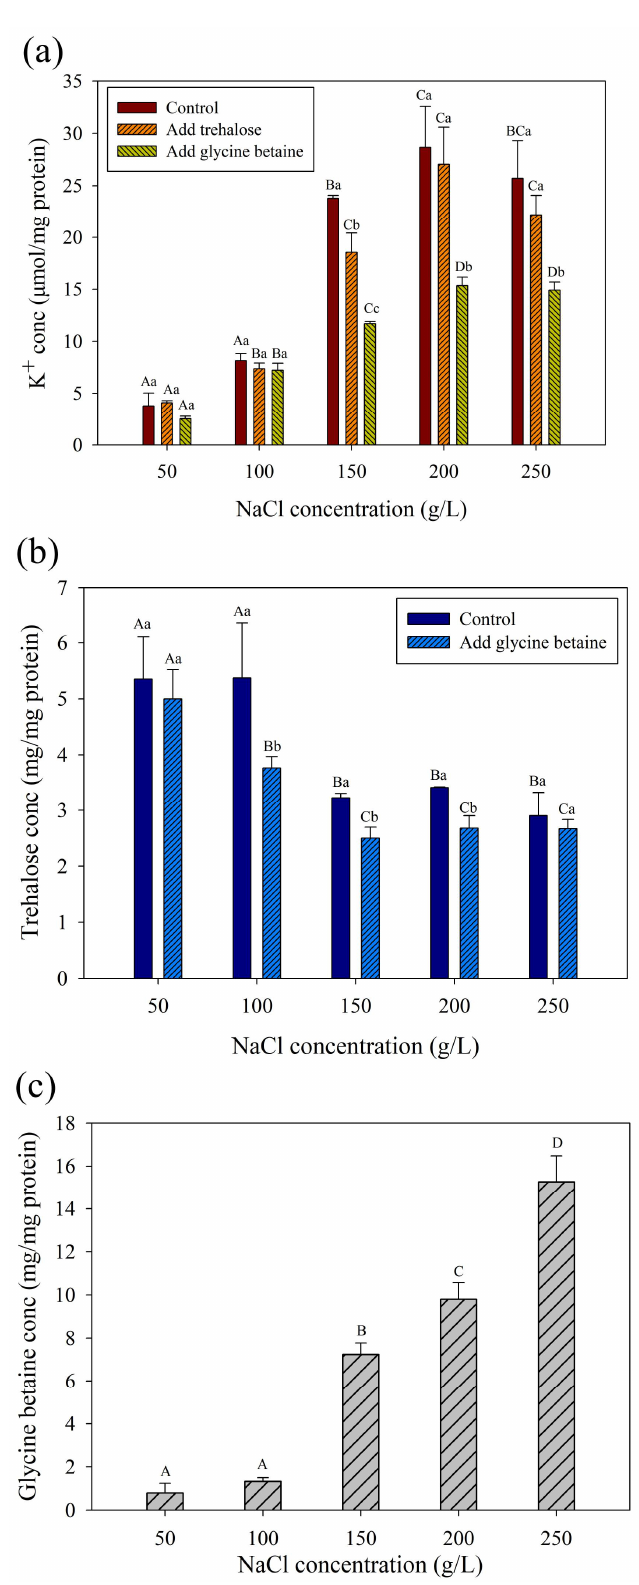
Figure 4. Intracellular K + ( a ), trehalose ( b ) and glycine betaine ( c ) concentration changes with the different NaCl concentrations. “A, B, C, D” refers to the significance analysis between groups with different NaCl concentrations (50–250 g/L). “a, b, c, d” refers to the significance analysis between groups with no extras, add 1% extra trehalose and add 1% glycine betaine.